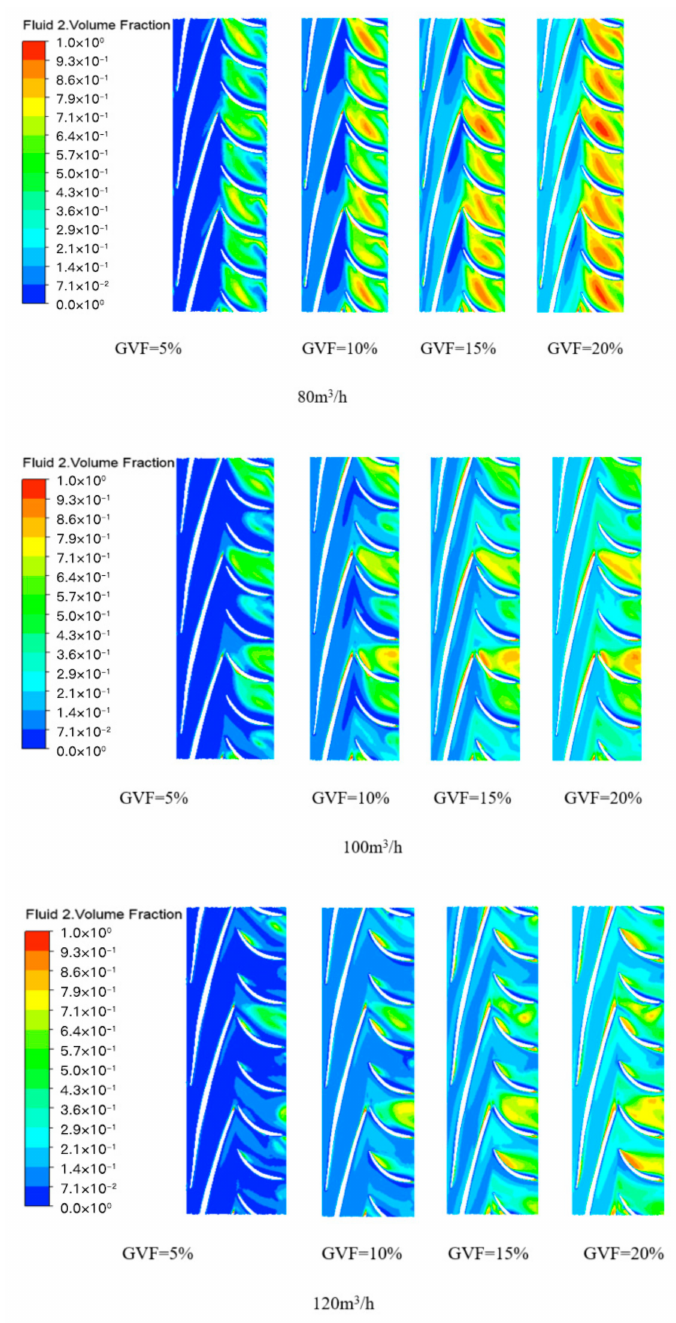
Figure 10. Gas in multiphase pump under different